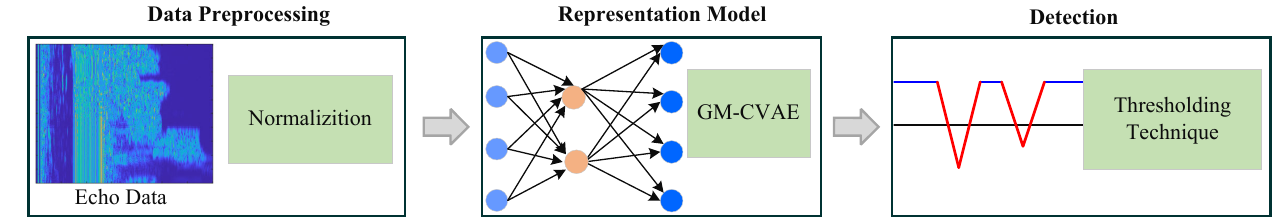
Figure 3. An overall framework for unsupervised target detection based on the GM-CVAE model. The framework mainly consists of three parts: data pre-processing, the representation model and detection.